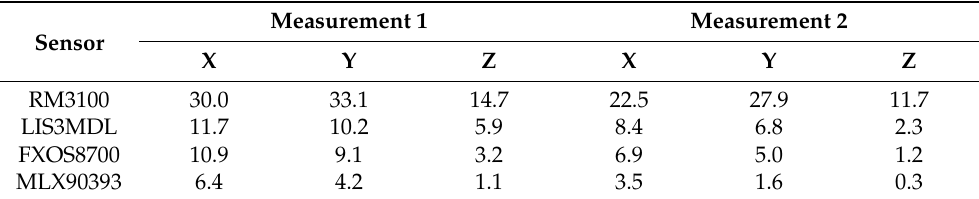
Table 5. Mean SNR [dB] of a passenger